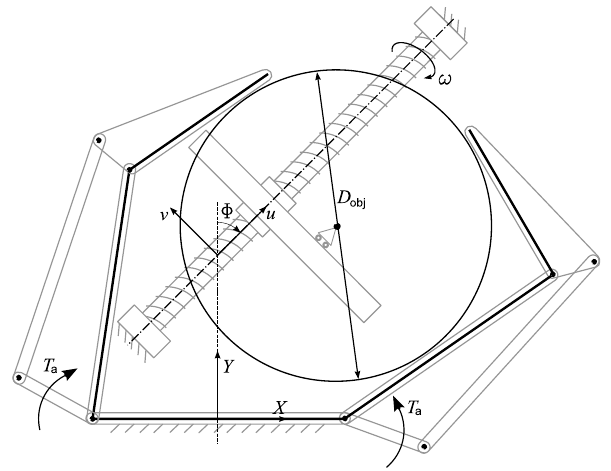
Figure 2. Schematic drawing of the setup where a cylindrical object with a diameter Dobj is pulled out of the hand at a constant slow speed ω in the direction u, while the fingers are actuated at a constant torque Ta. The object is free to move in the direction v, which is perpendicular to u. The resultant of the contact forces on the object in the pull direction u is measured.